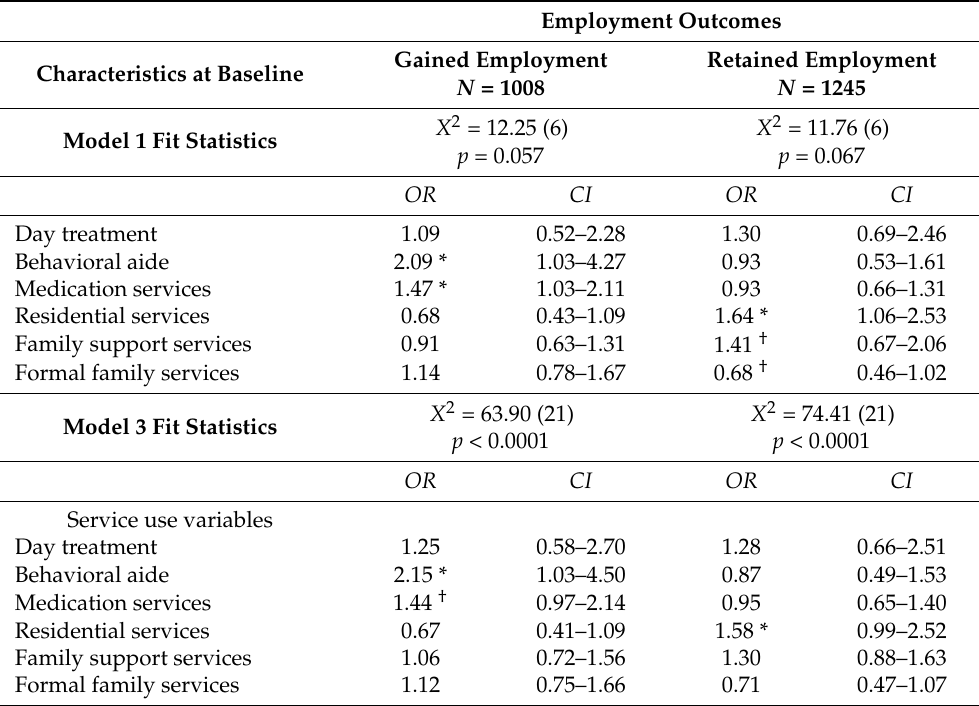
Table 3. Regression Analyses Predicting Employment Outcome: Types of